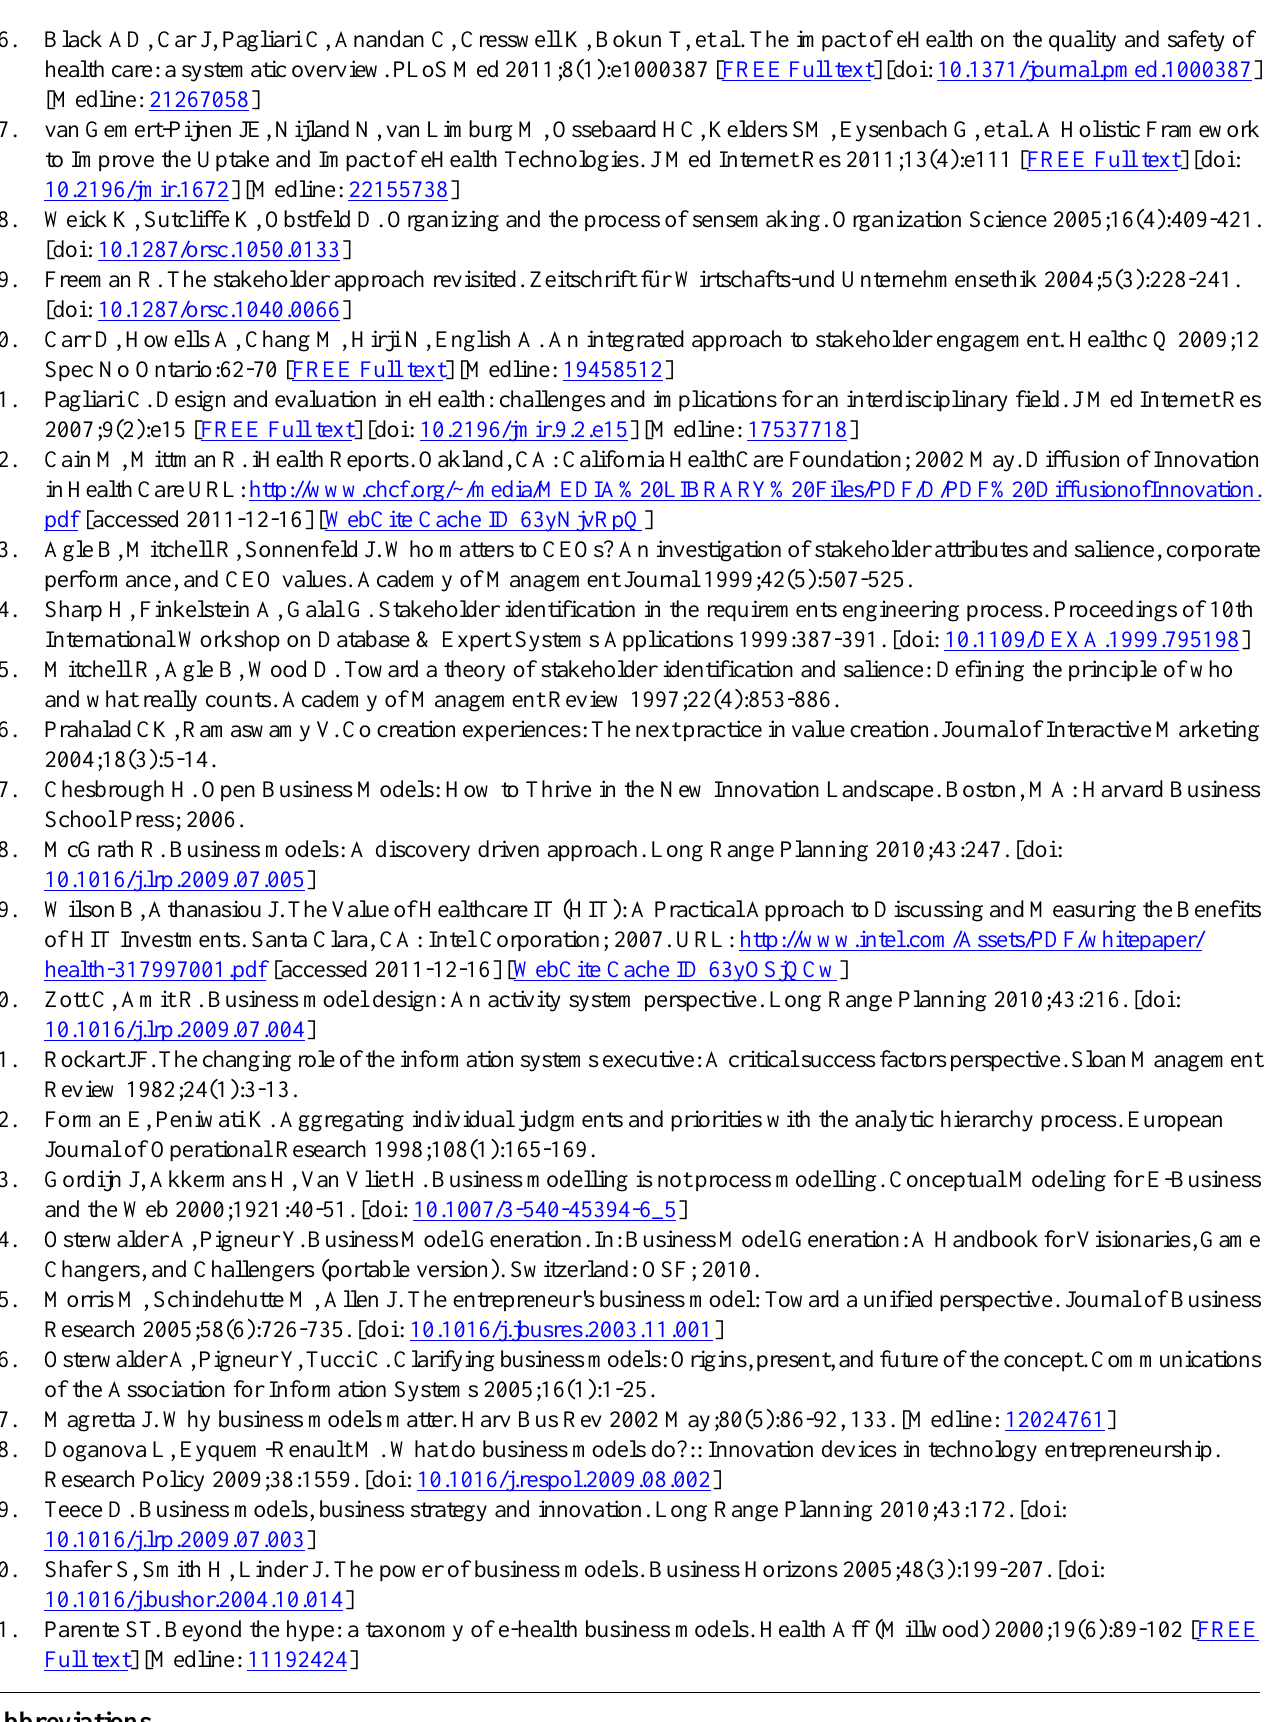
CeHRes: Center for eHealth Research and Disease